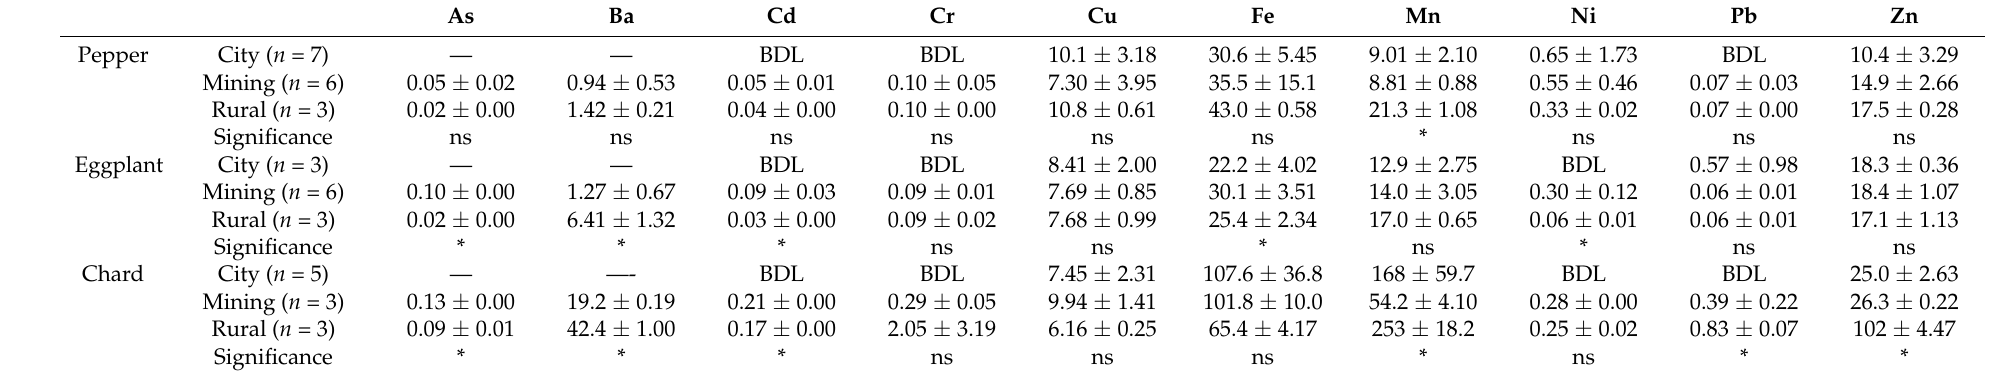
Table 2. Potential toxic element accumulation in pepper, eggplant, and chard cultivated in different urban gardens. Values are mean ± standard deviation expressed as mg kg − 1